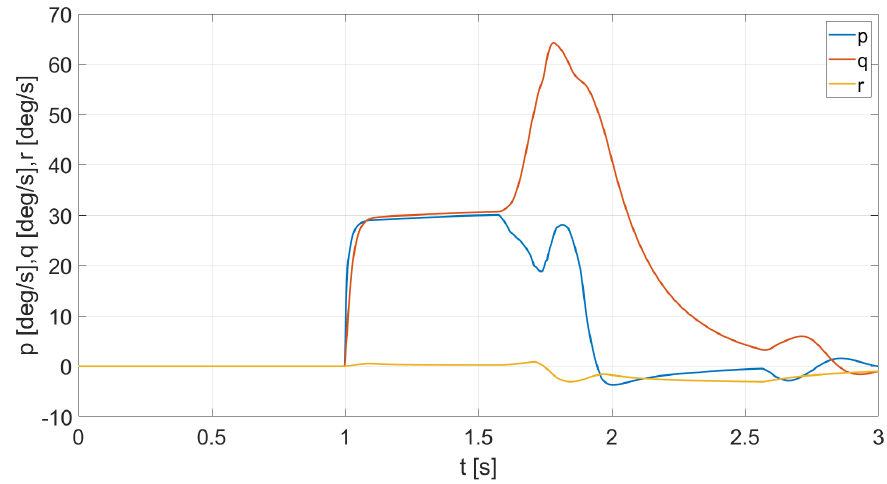
Figure 8. UAV angular speed response—PID-SDRE control mode, t f = 2 s.